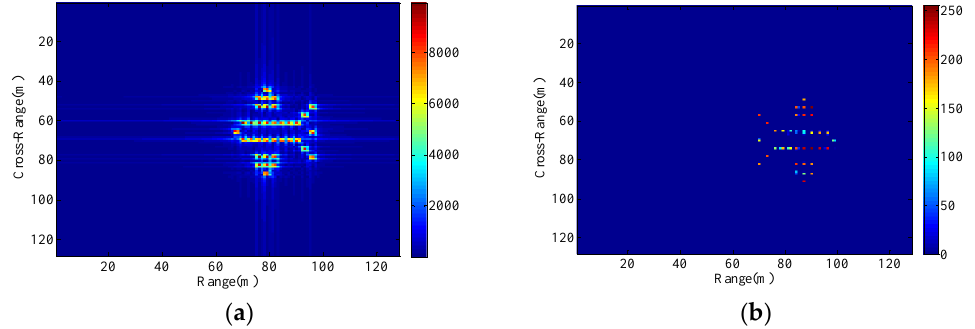
Figure 5. Imaging results with the radar platform displacement parameters P1. ( a ) RD algorithm; ( b ) the proposed method.